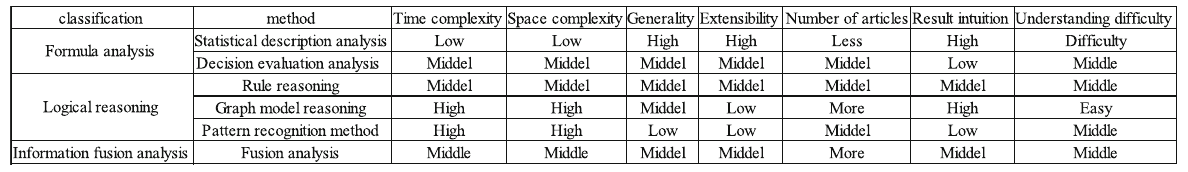
Table 11 Comparison between analytical